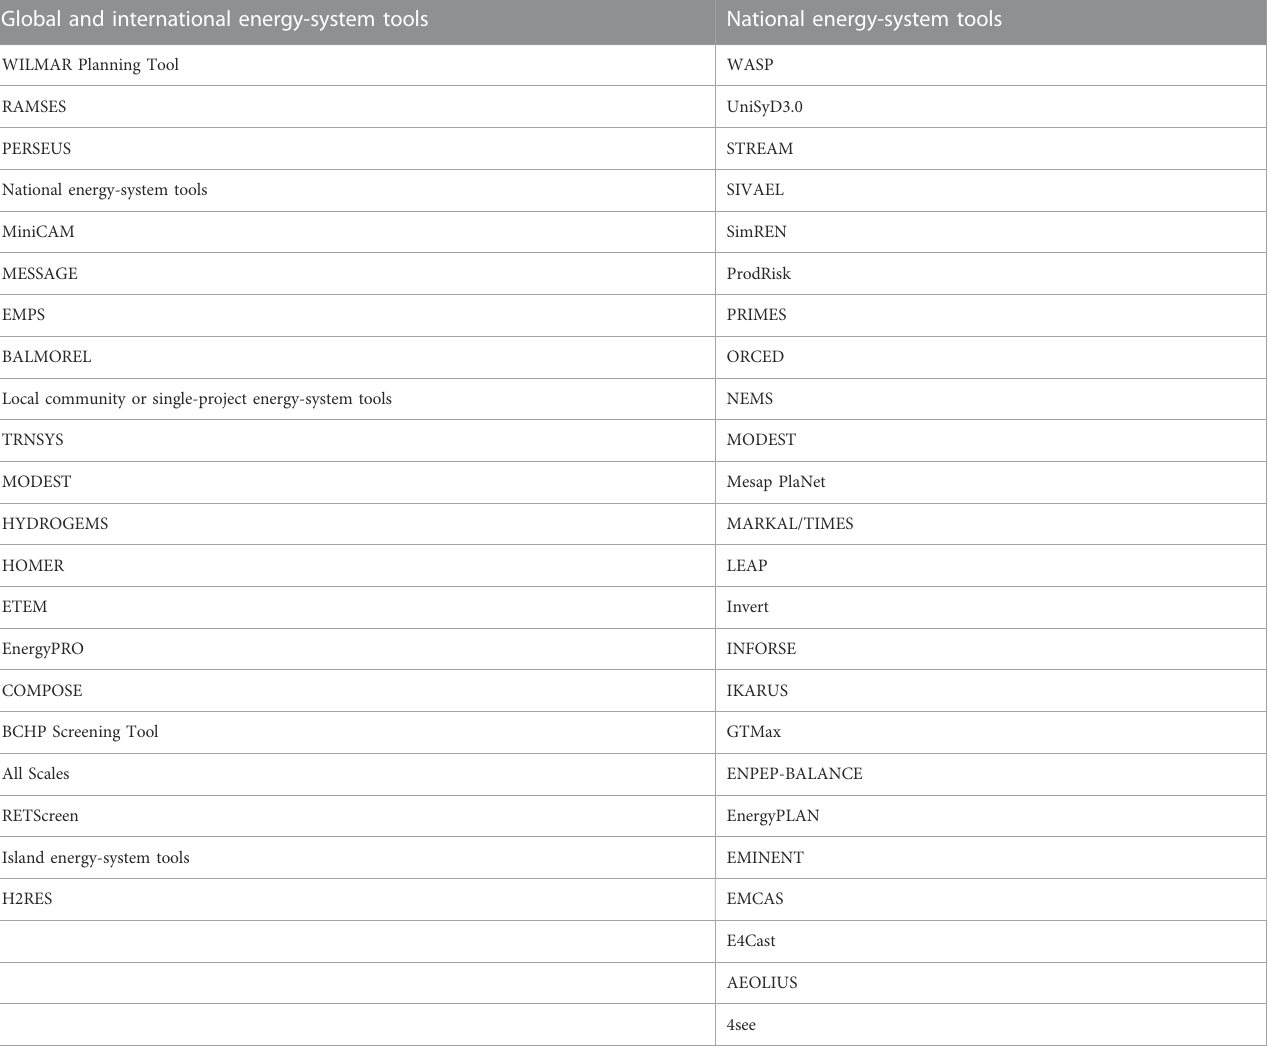
TABLE2Classi fi cationbasedonglobalsizingtools,islandenergy-systemtools,single-projectorlocalcommunity-basedsizingtools,nationalenergy-systemtools,and tools that can handle all scales (Ajeigbe et al., 2020). Global and international energy-system